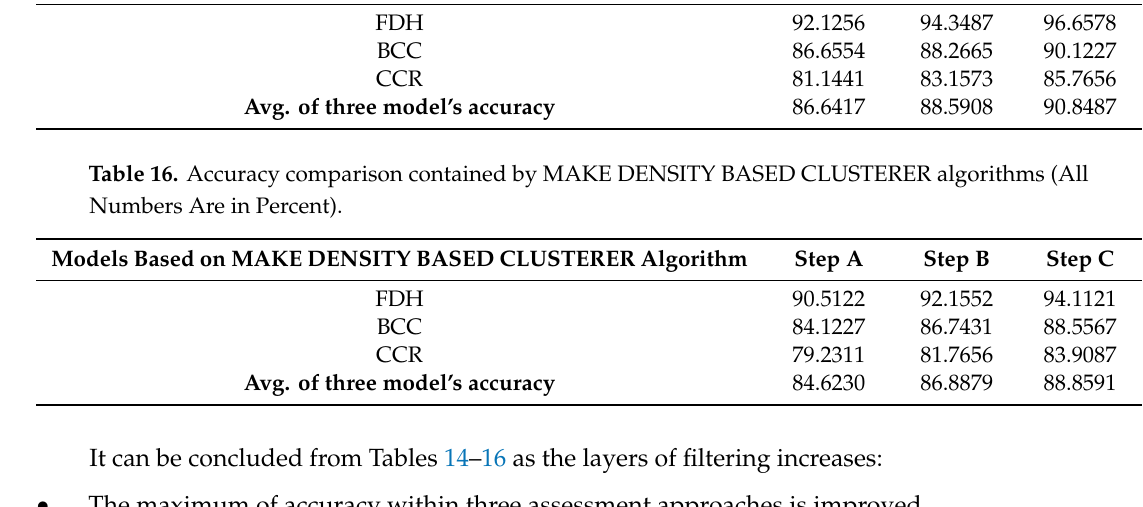
Table 15. Accuracy comparison contained by HIERARCHICAL CLUSTERER algorithms (All Numbers Are in Percent). Models Based on HIERARCHICAL CLUSTERER Algorithm Step A Step B